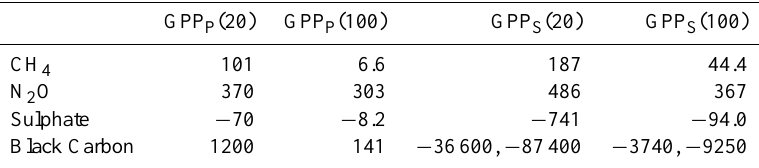
Table 4. The GPP P and GPP S , relative to CO 2 , for pulse emissions of four other species at time horizons of 20 and 100 years, which are chosen for illustrative purposes, using the values of surface–atmosphere partitioning of radiative forcing from Kvalevåg et al. (2013). The two black carbon values are, respectively, using values of f for a model-derived vertical profile for present-day emissions and assuming that the present-day burden is placed entirely at 550hPa. The absolute values of metrics for CO 2 are given in Table 1. GPP P (20) GPP P (100)